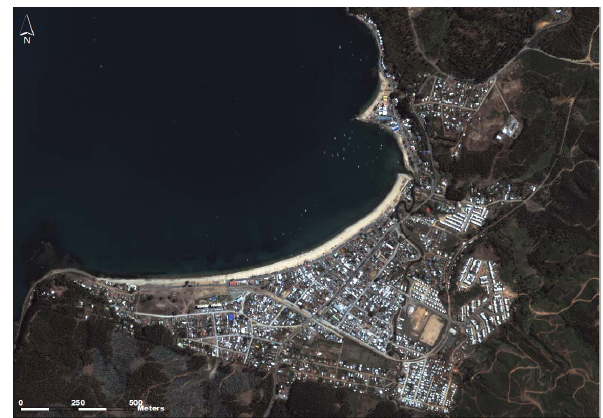
Fig. 3. Satellite image taken before the tsunami event in Dichato (Chile) – 10 February